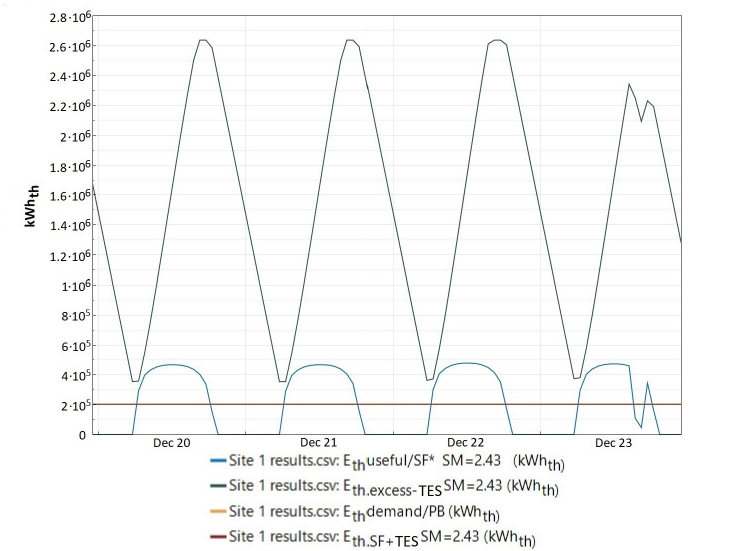
Figure 4. Evolution of the main simulated thermal variables around the design day through the proposed mathematical model—site 1 case.